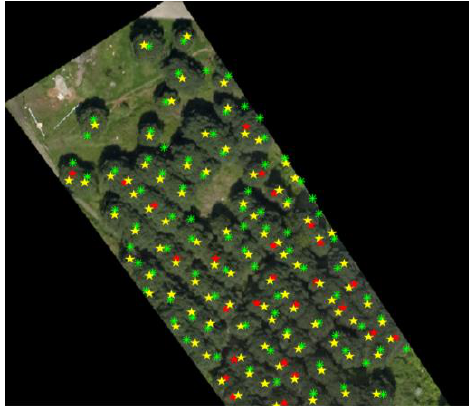
Figure 6. Detected and non-detected